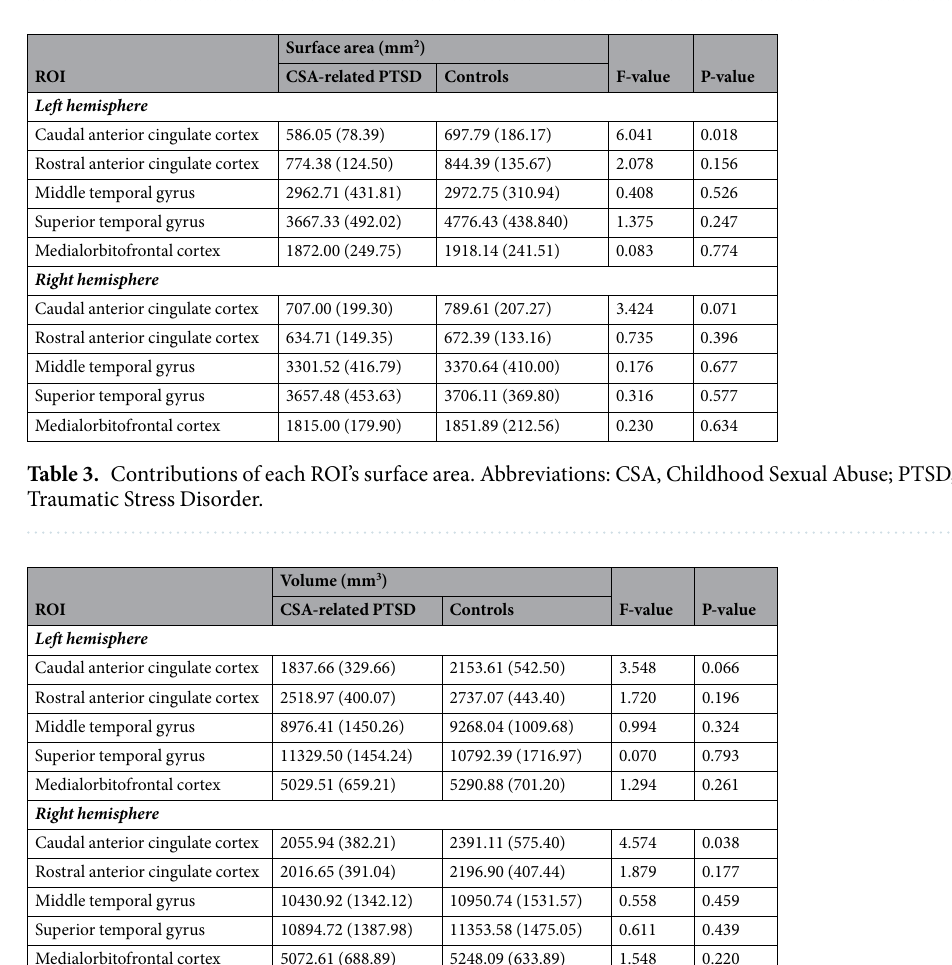
Table 2. Contributions of each ROI’s cortical thickness. Abbreviations: CSA, Childhood Sexual Abuse; PTSD, Post Traumatic Stress Disorder.